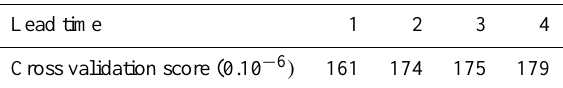
Table 8. Evolution of the cross-validation score versus the forecast